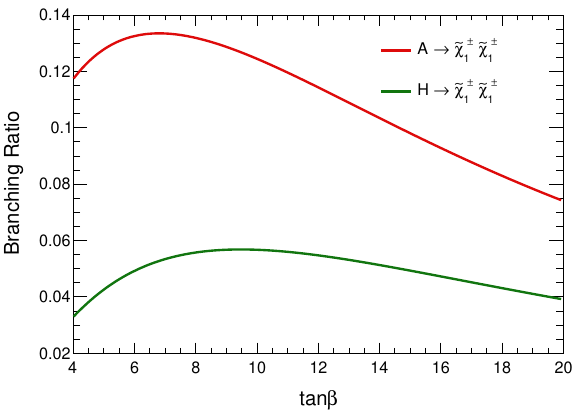
) between Suspect2 e χ ± 1 − e χ 0 1